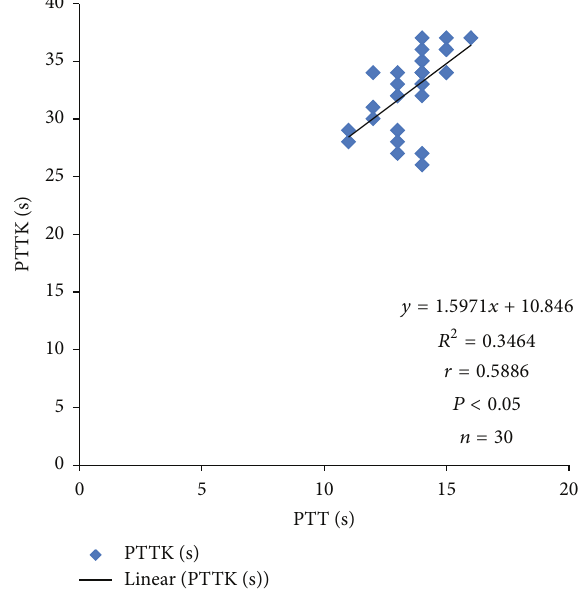
Figure 6: Correlation plot of PTTK against PTT in normotensive subjects.